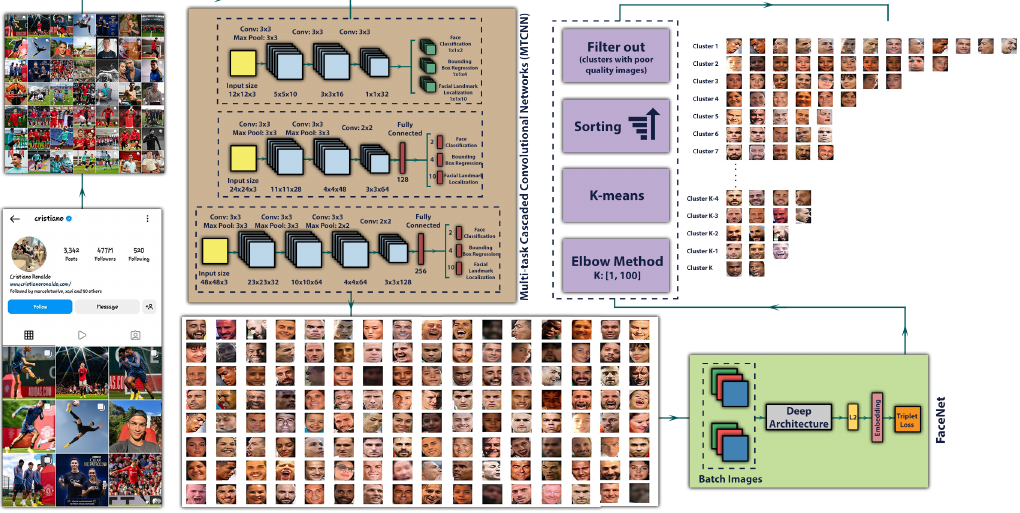
Figure 5. The procedure of face recognition. The images of MTCNN and FaceNet architecture are taken from the corresponding referenced